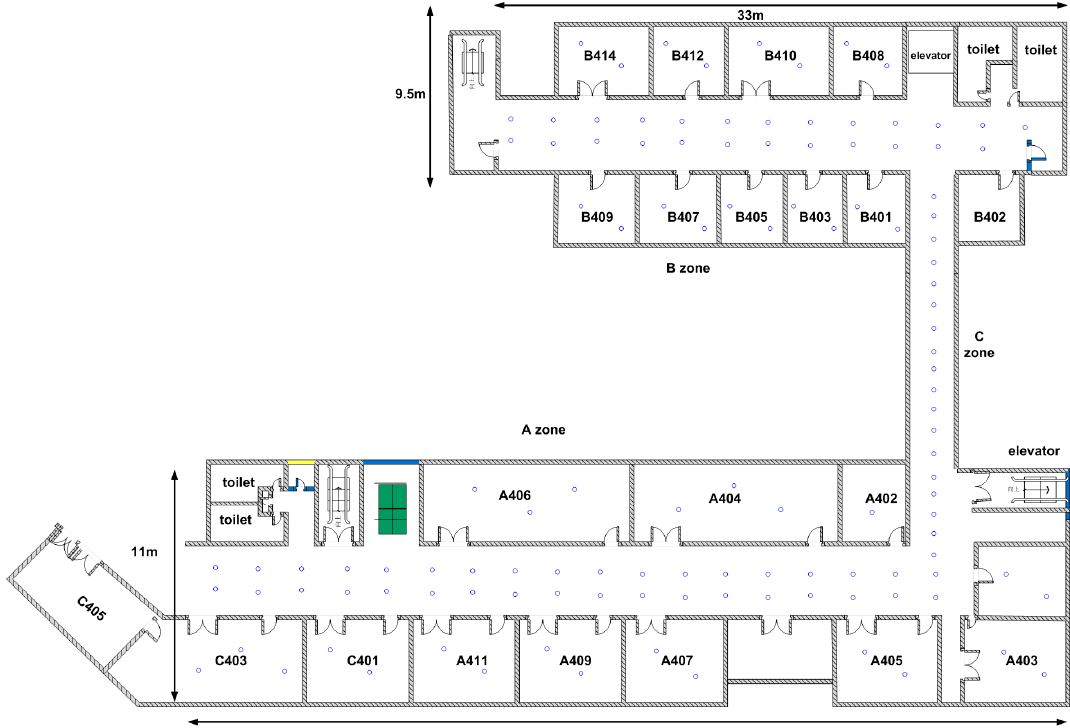
Figure 2. Layout of the experimental field.